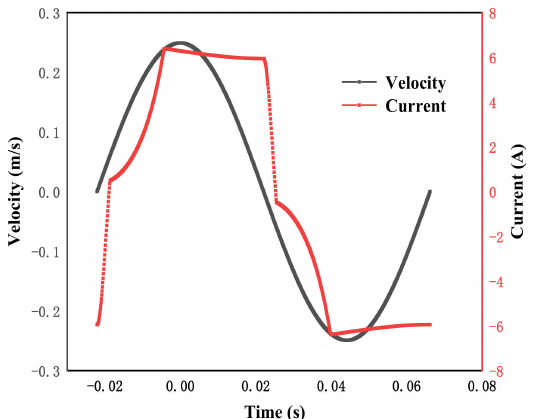
Figure 6. The calculated current and speed curves of the